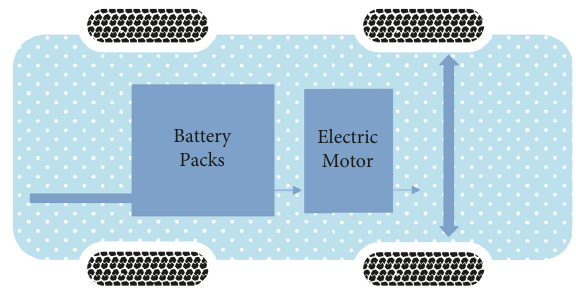
Figure 1: HEV car representation.